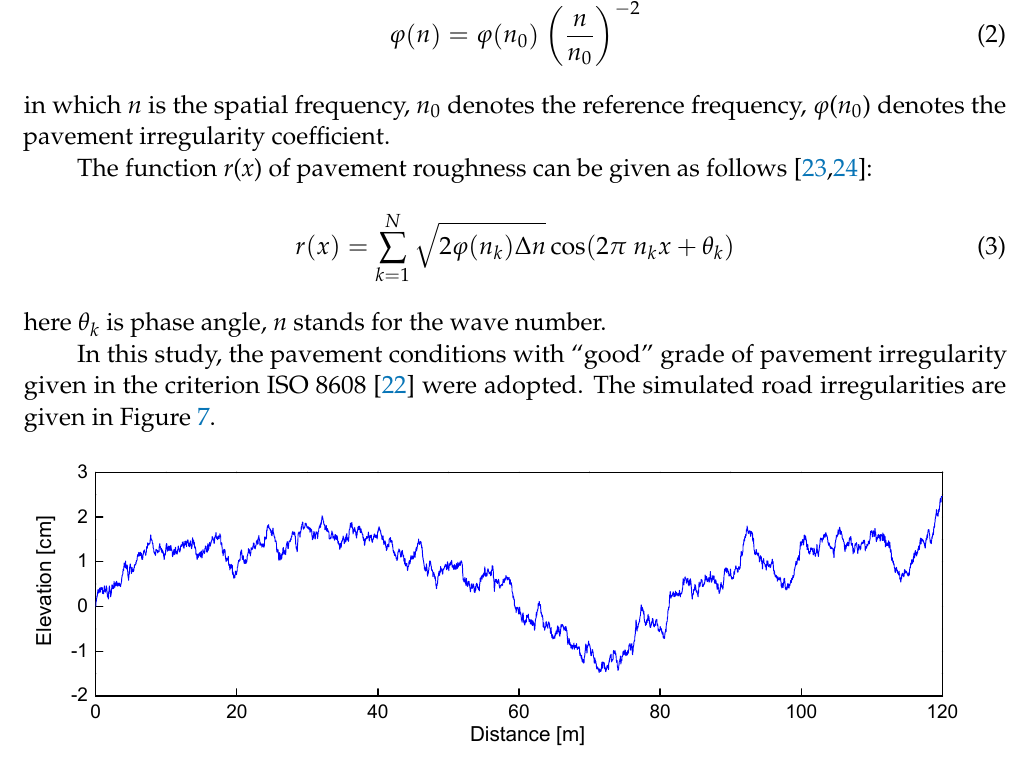
Figure 7. Simulated road irregularities in this study.